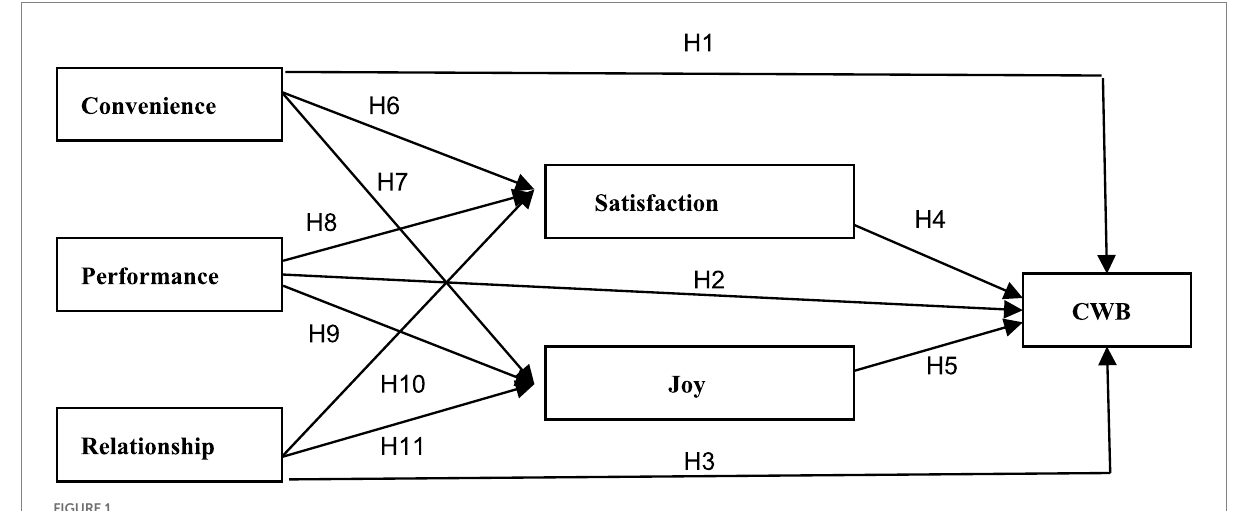
FIGURE 1 The conceptual model. H12, H13 and H14 are mediation